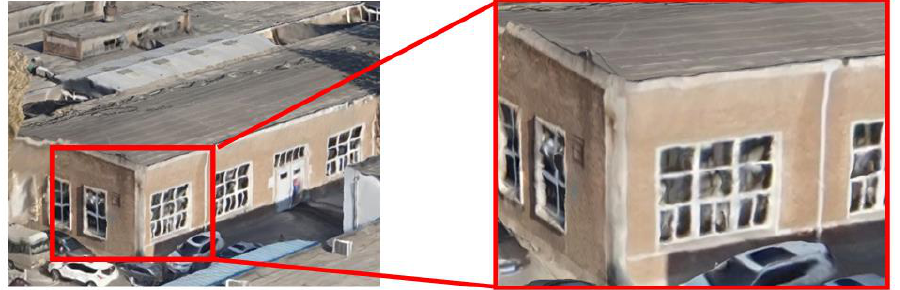
Figure 7 The model constructed only by the oblique photogrammetry